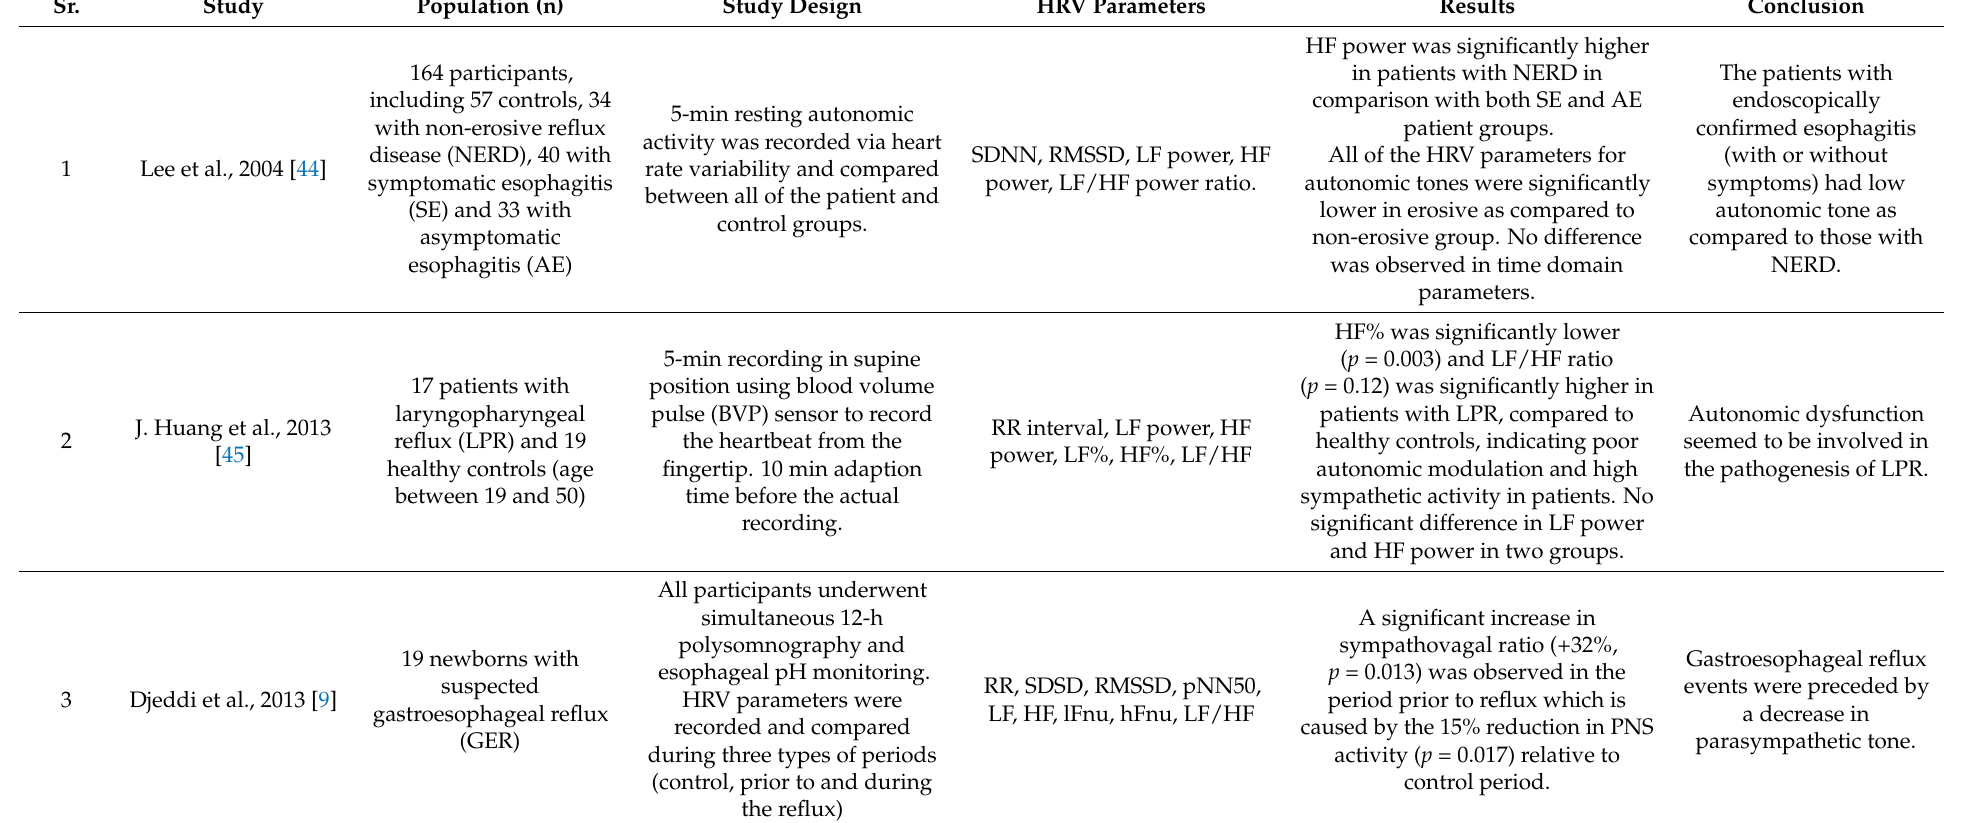
Table 2. Summary of Studies: Autonomic Nervous System and Gastroesophageal Reflux.